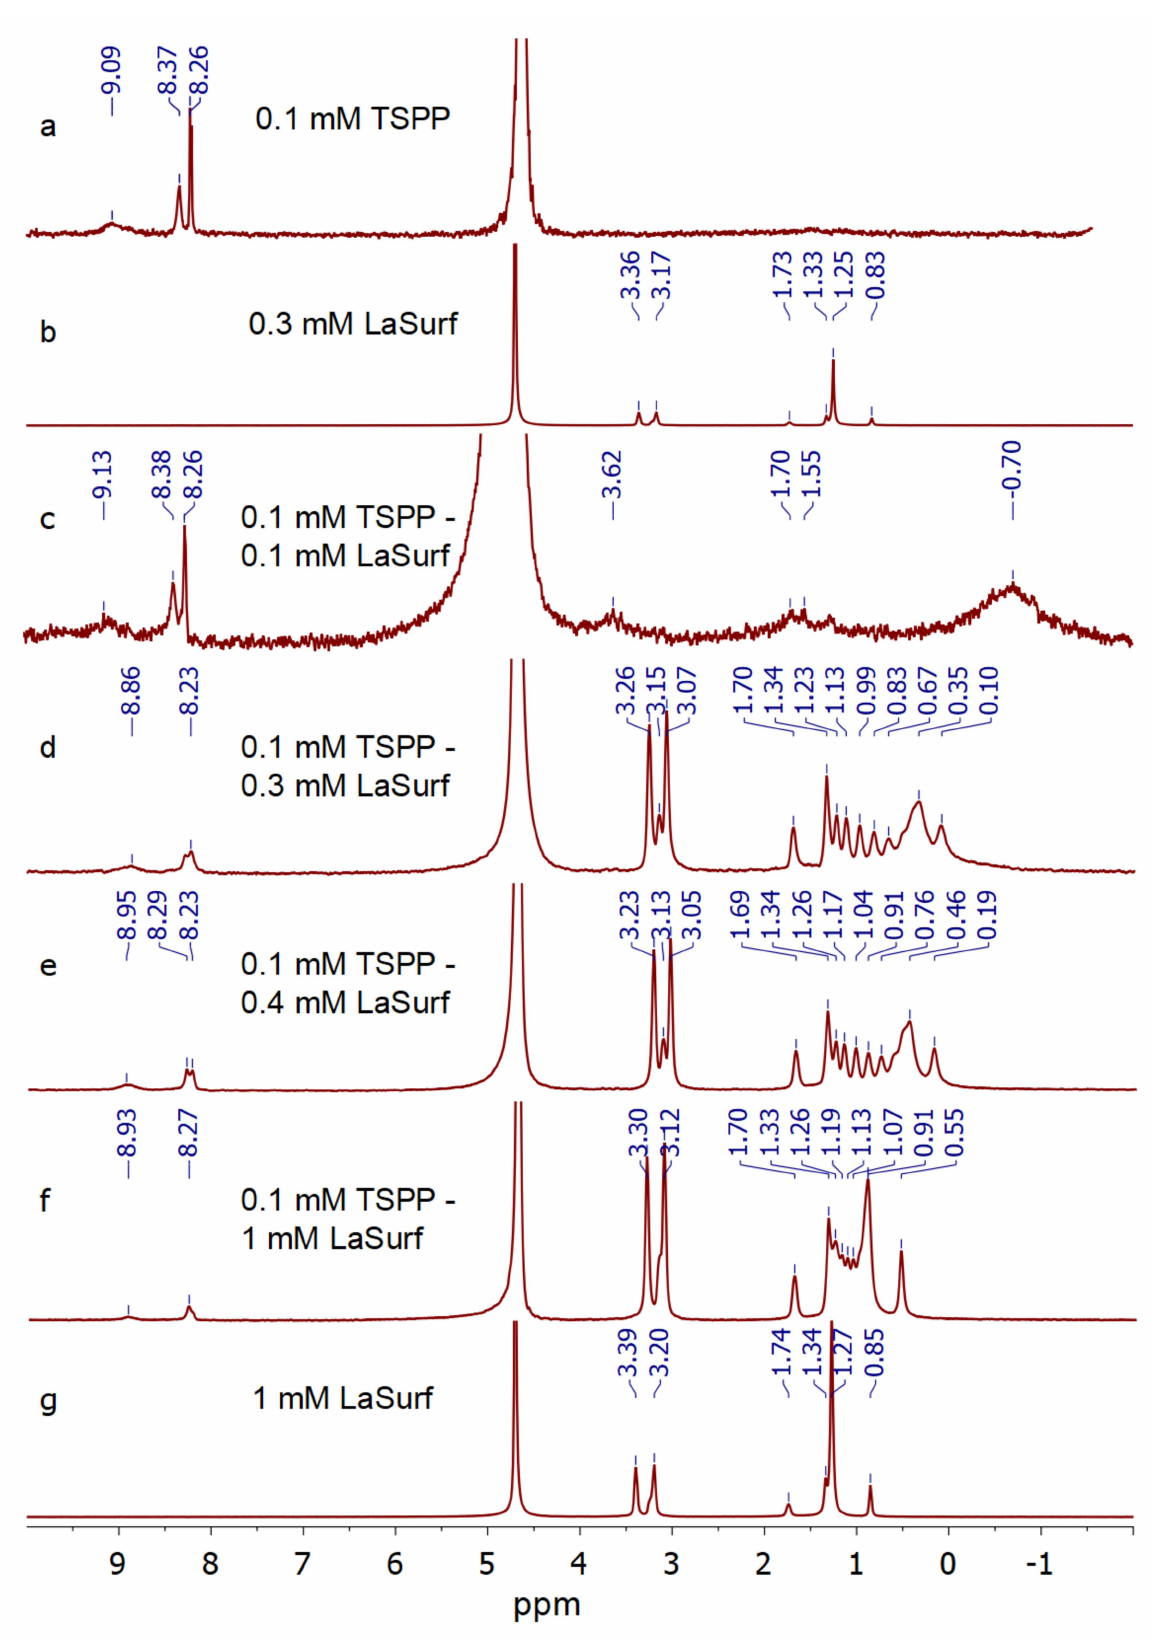
Figure 5. 1 H NMR spectra of pure ( a ) 0.1 mM TSPP, ( b ) 0.3, and ( g ) 1 mM LaSurf, as well as 0.1 mM TSPP in the presence of ( c ) 0.1, ( d ) 0.3, ( e ) 0.4, and ( f ) 1 mM LaSurf in D 2